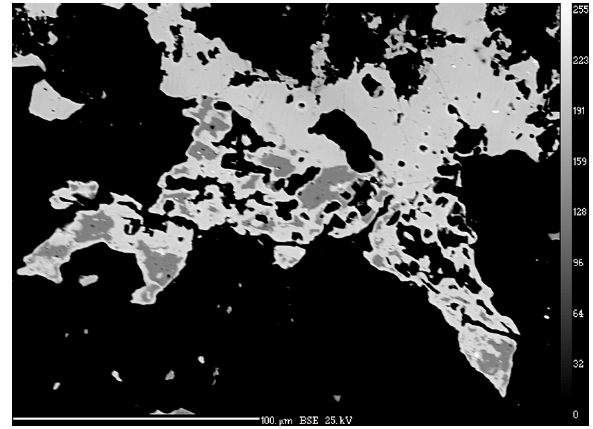
Figure 32. Eskebornite grains (dark grey) in hakite aggregates (light grey). BSE photograph. P ř íbram, a dump of shaft 16. Photo by J. Sejkora, P. Škácha.